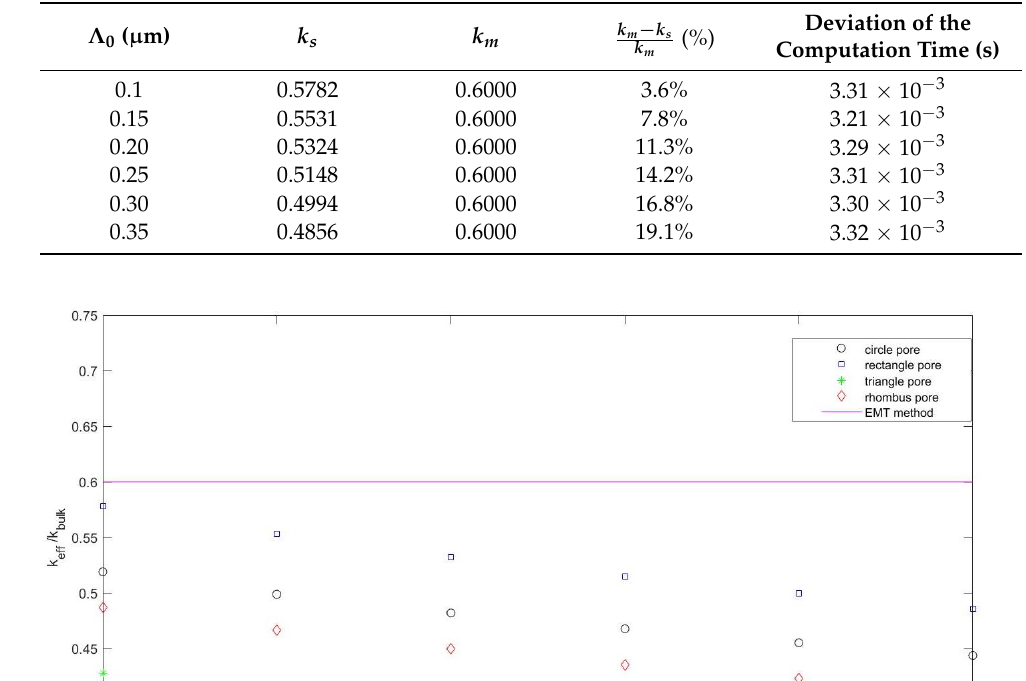
Table 2. The effective thermal conductivity of rectangle pores compared with the EMT method.